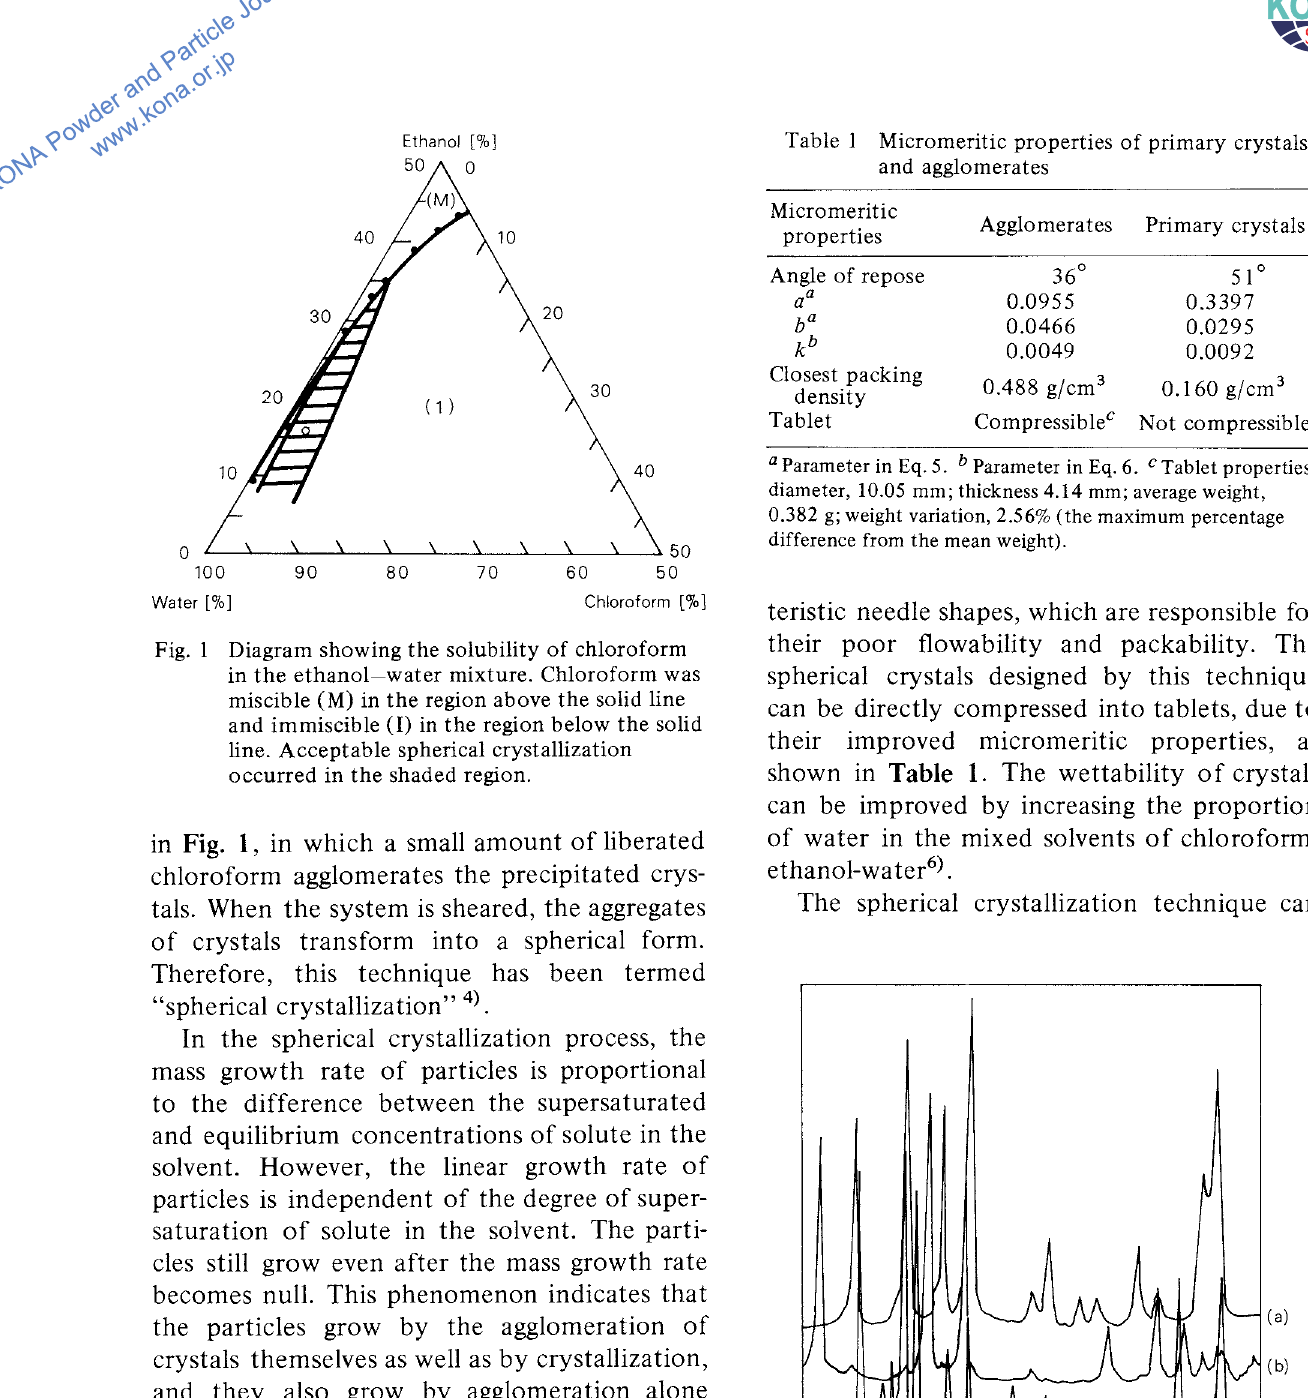
Fig. 2 X-ray powder diffraction patterns of agglomerates, anhydrous theophylline, theophylline monohydrate, and